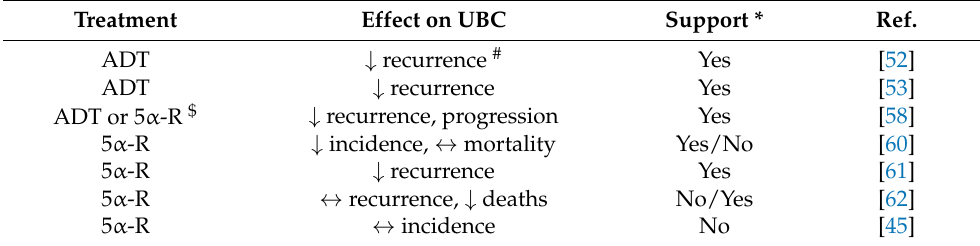
Table 1. Effects of Androgen-Based Therapy on UBC Recurrence, Progression, and Mortality. Treatment Effect on